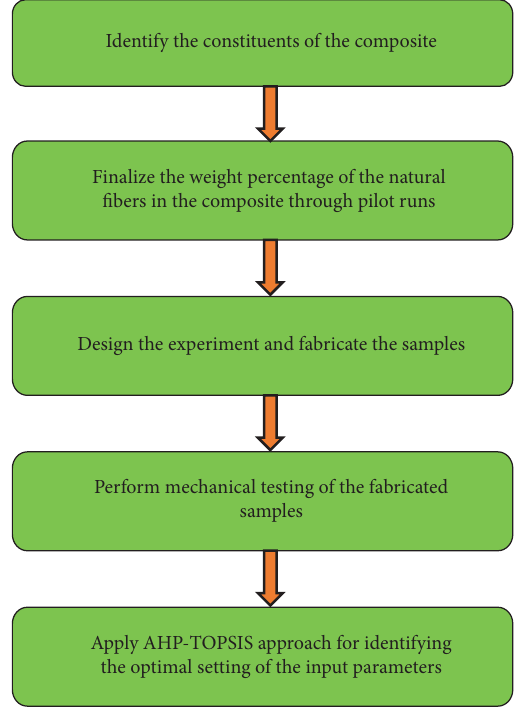
Figure 1: Workflow and methodology used for the mechanical performance of natural fiber-based green composites.